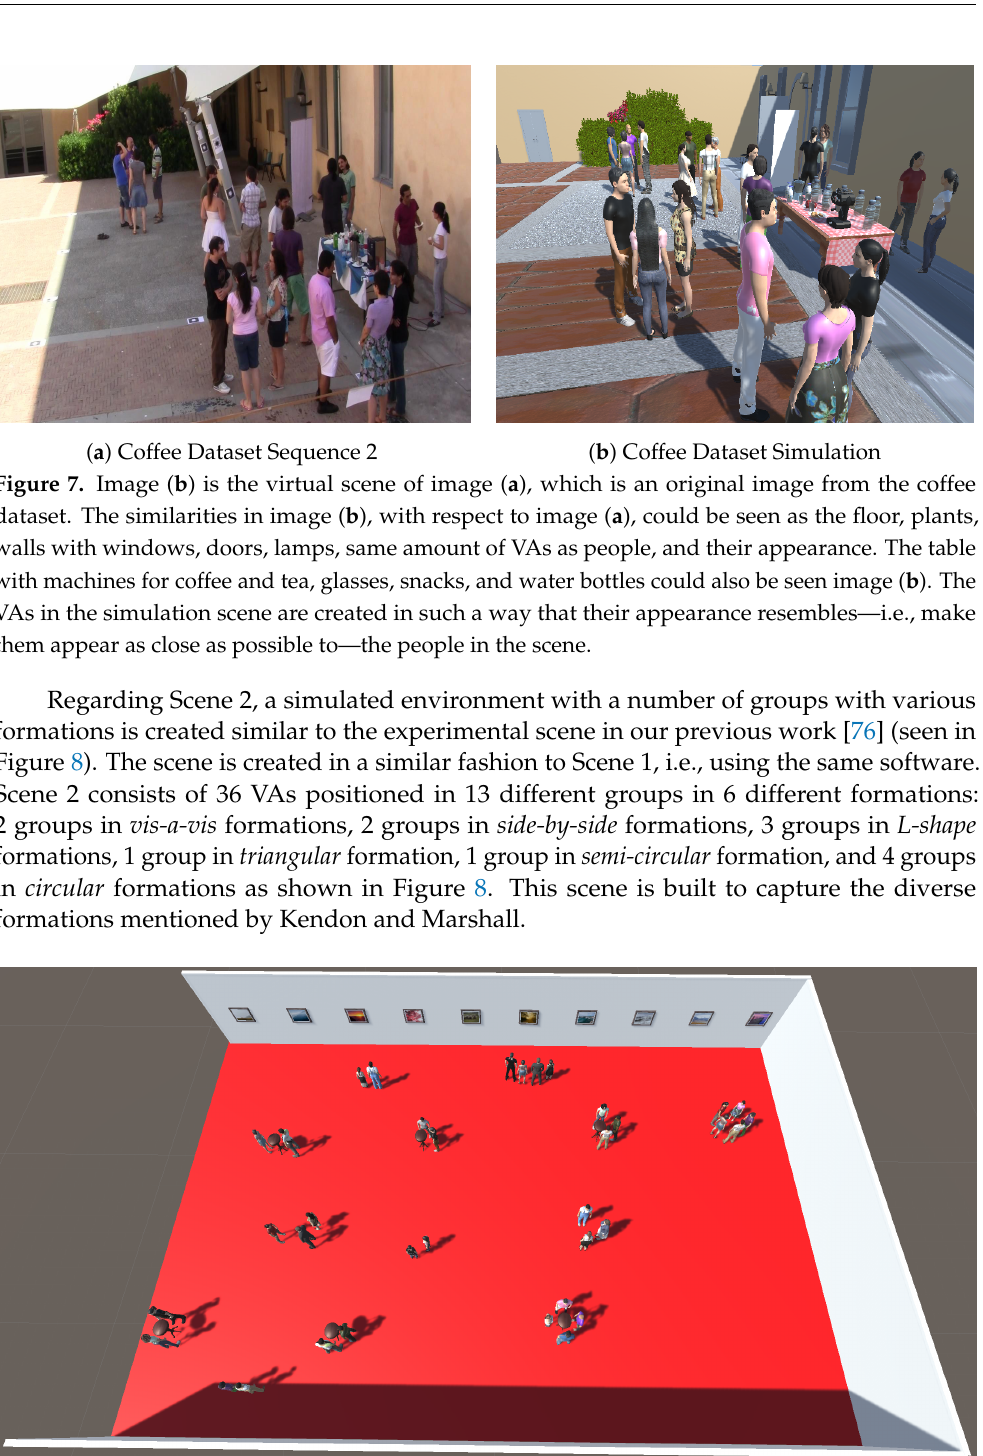
Figure 8. The global view of the virtual Scene 2, which resembles a conference break social interaction scenario similar to the experiment scene of our previous work [76]. The scene consists a large hall with a red carpet, walls, paintings on the wall, round pub-style tables, and the VAs positioned in a number of groups with varying sizes in different